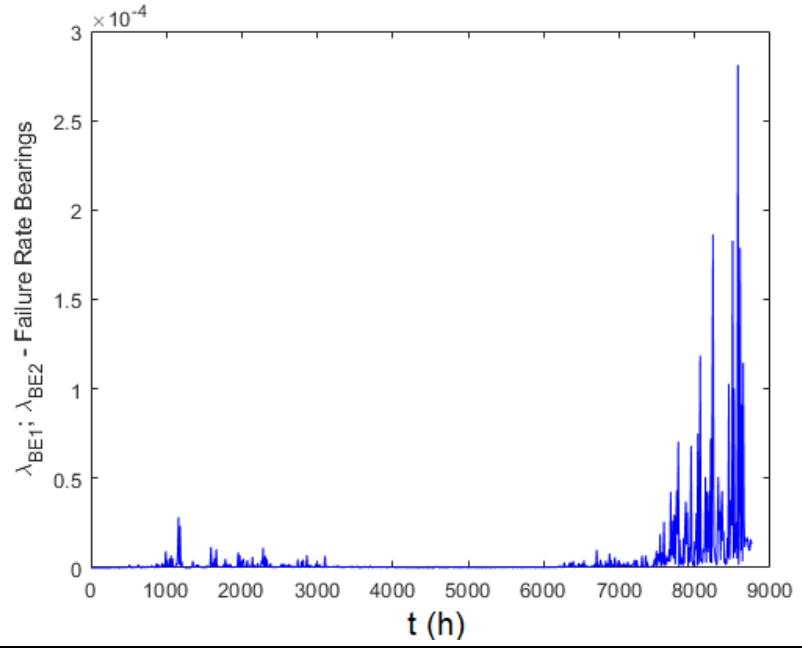
Figure 12. Failure rate of the bearings of the electric motor case study.